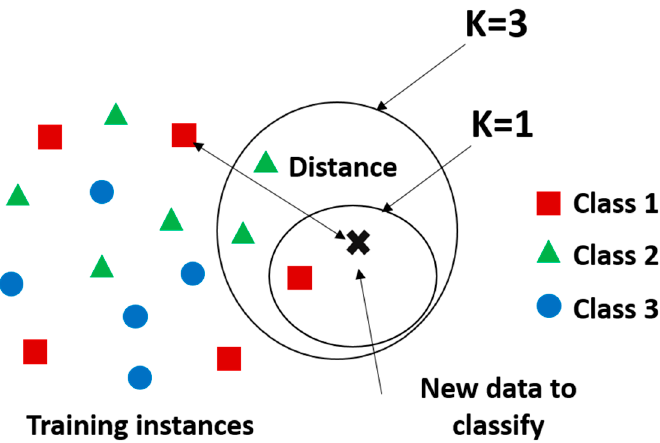
Figure 7. Example of KNN classification. The test sample (cross) should be classified to one of the three classes. If K = 3 (outside circle), it is assigned to the second class because there are two triangles and only one square inside the inner circle.